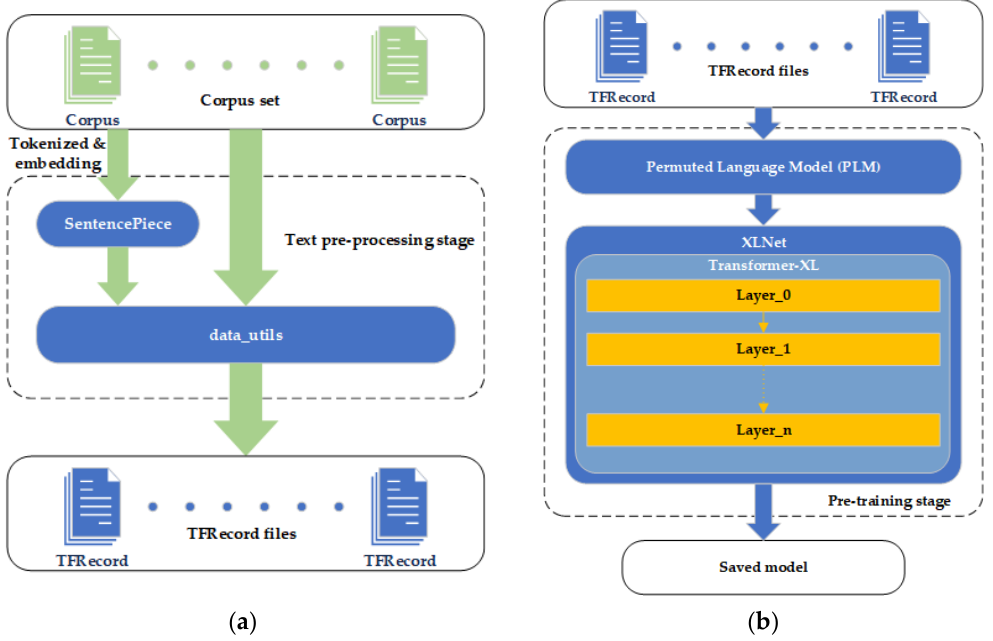
Figure 1. XLNet training process. ( a ) The text pre-processing process; ( b ) The pre-training process.